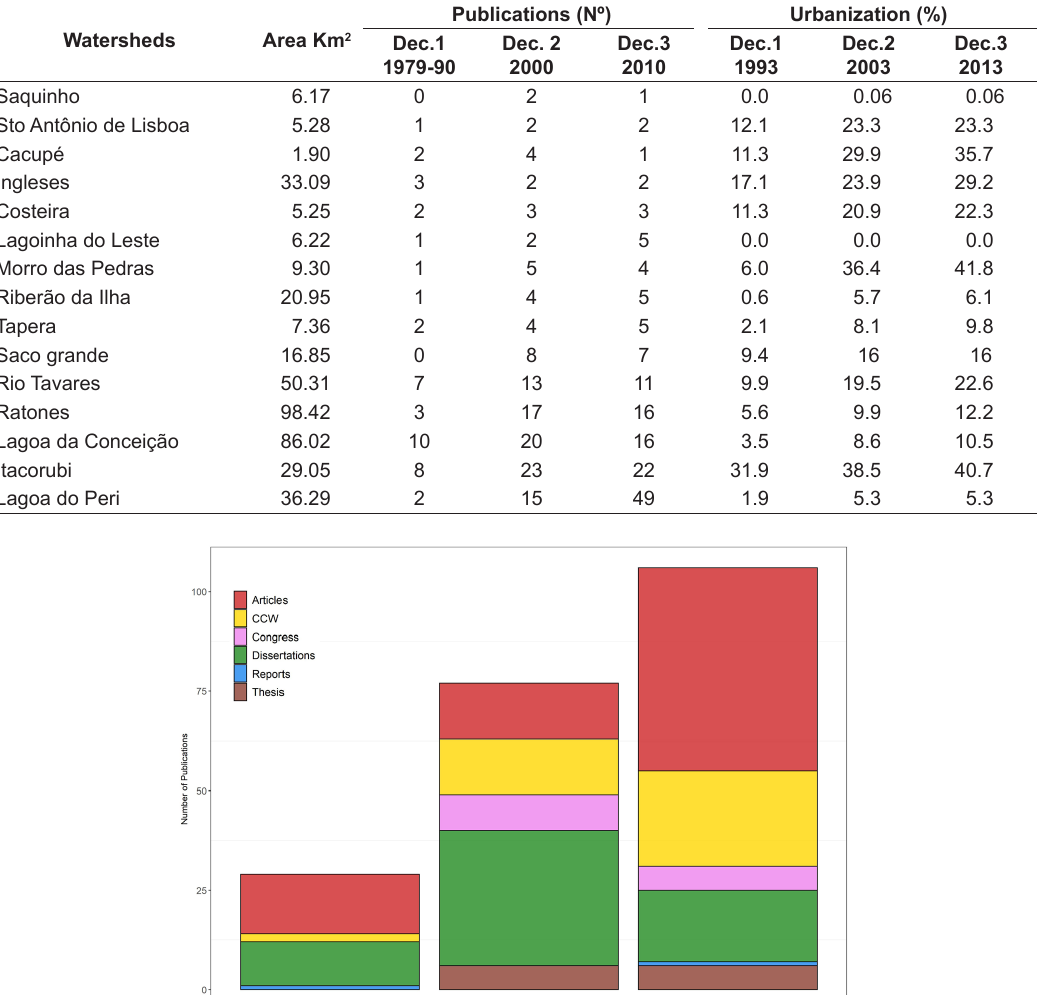
Table 1. Watersheds studied in Santa Catarina Island, drainage areas, number of studies, and urbanization percentage of the last three decades.